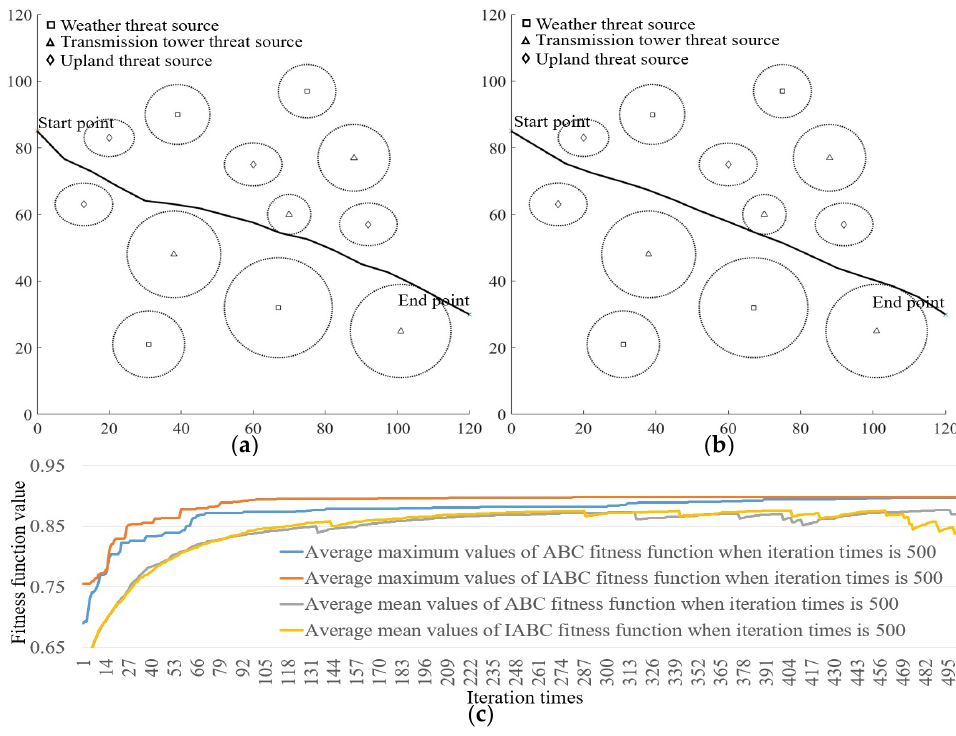
Figure 11. Examples of path planning and statistical results of fitness function using 500 iterations. ( a , b ) Path planning examples of ABC and IABC when iteration times is 500. ( c ) Statistical results of fitness function of ABC and IABC when iteration times is 500.